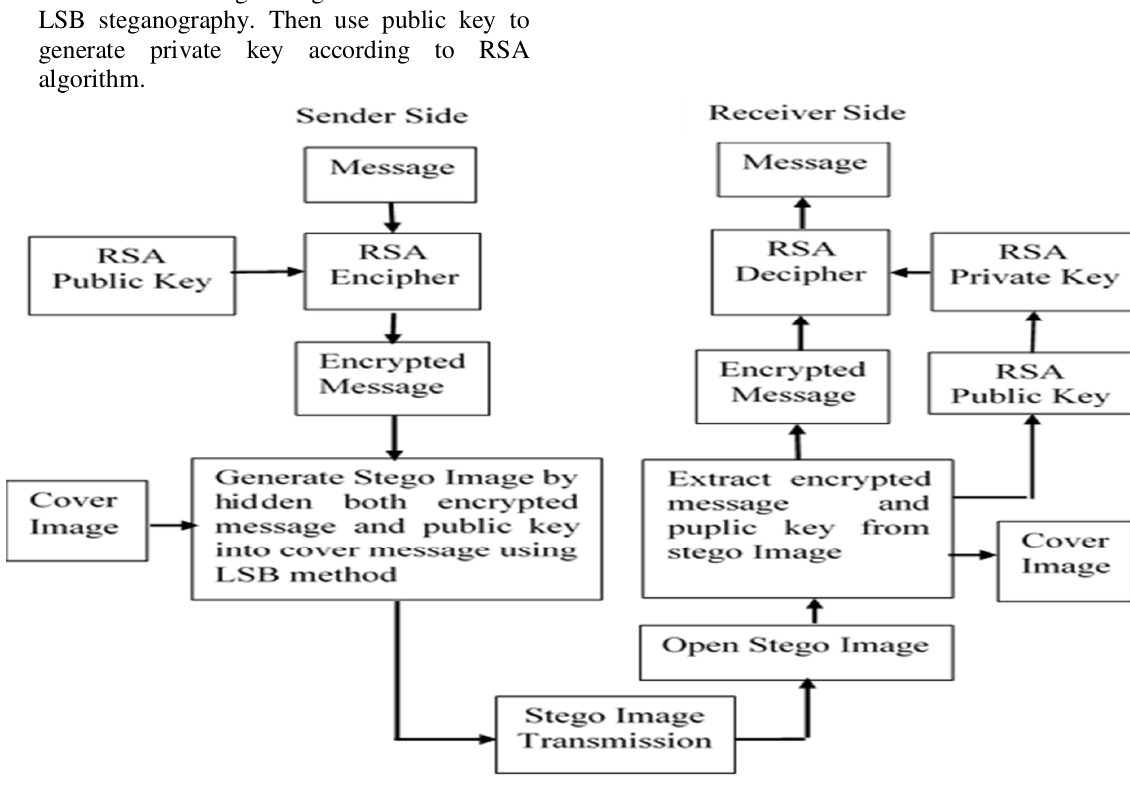
Fig. 2. Proposed system